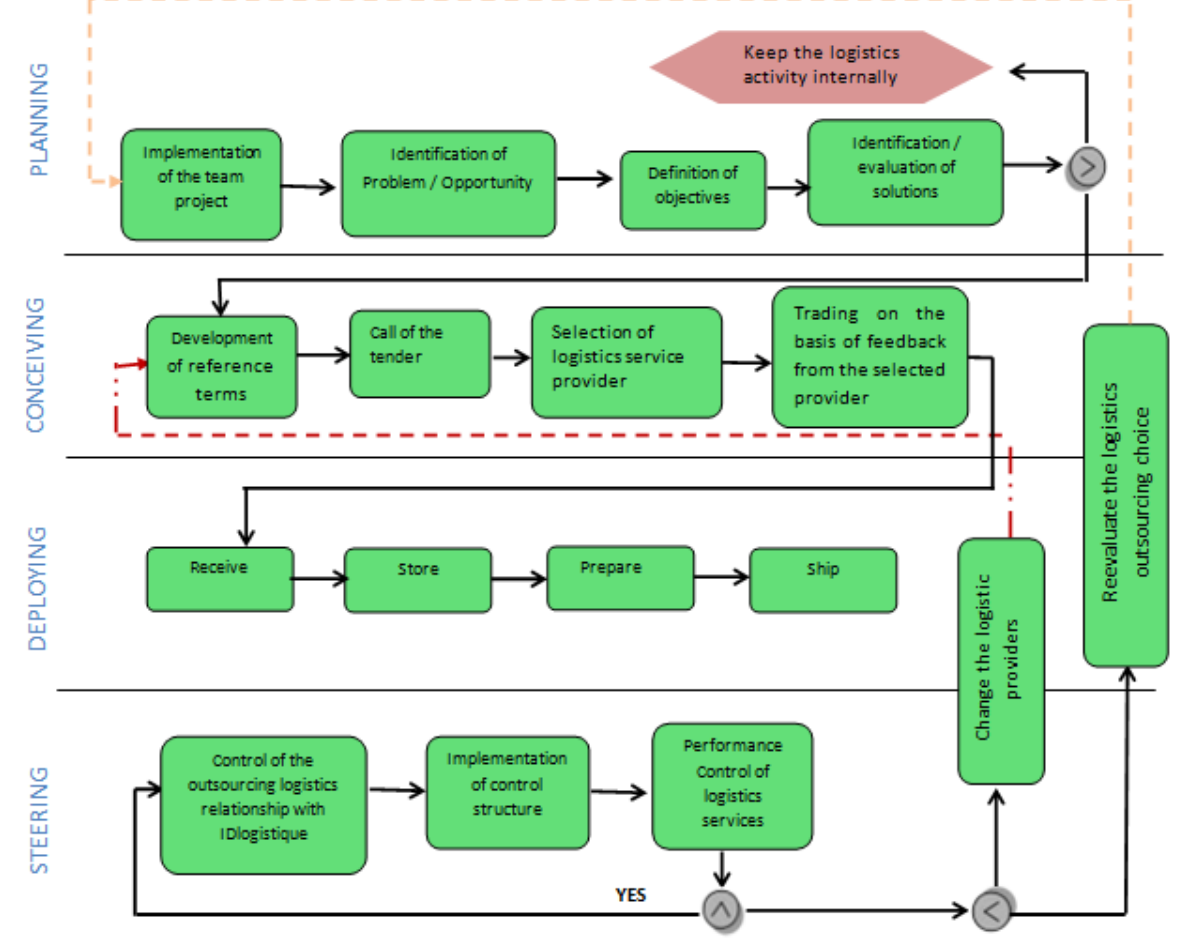
Figure 4. The modeling of logistics outsourcing